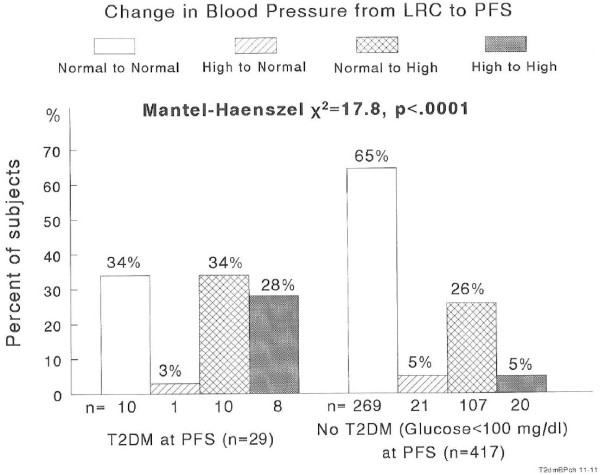
Changes in BP status groups from childhood to adulthood by adult T2DM status.